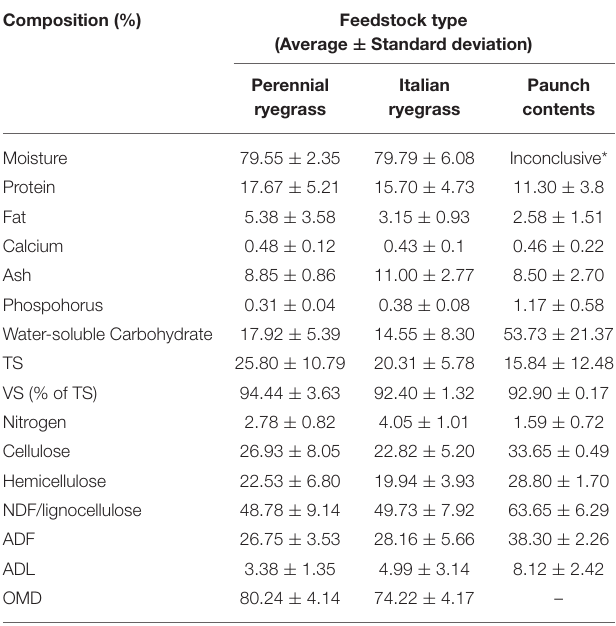
TABLE 1 | Composition of perennial ryegrass, Italian ryegrass and paunch